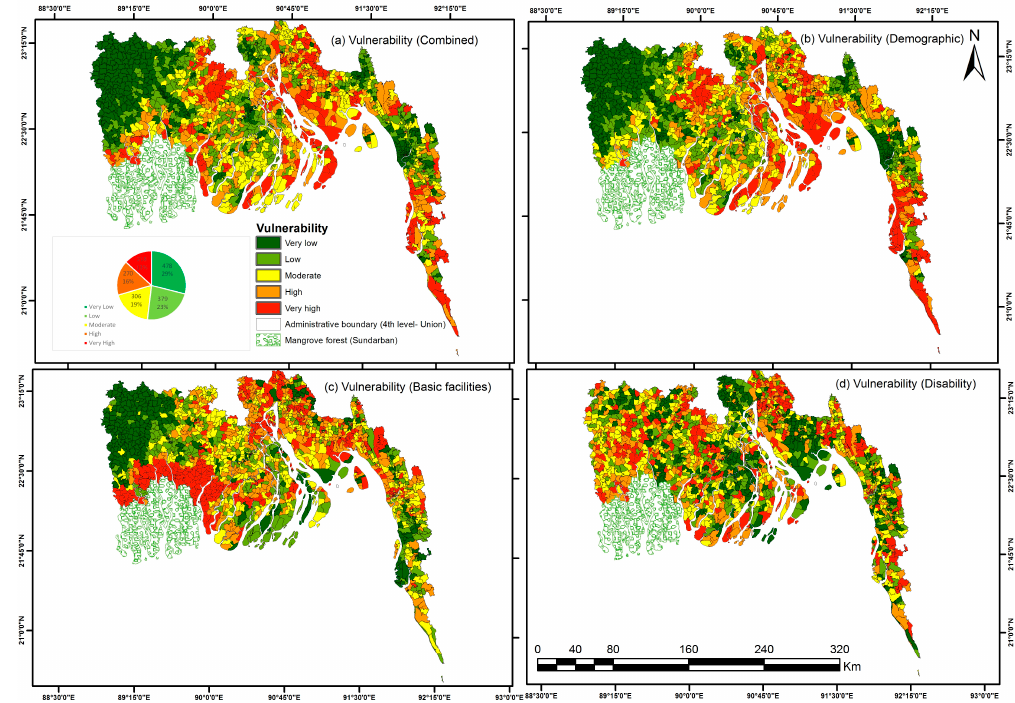
Figure 4. Vulnerability Map of Study Area. Vulnerability scores has been calculated based on 13 dimensions (Factors by PCA) from 41 social indicators. Maps of three major characteristic group of vulnerability are shown in: ( b ) Demographic; ( c ) Basic facilities; and ( d ) Disability. The overall vulnerability is shown in map ( a ) vulnerability (combined). Southwestern mangrove forest was kept out of